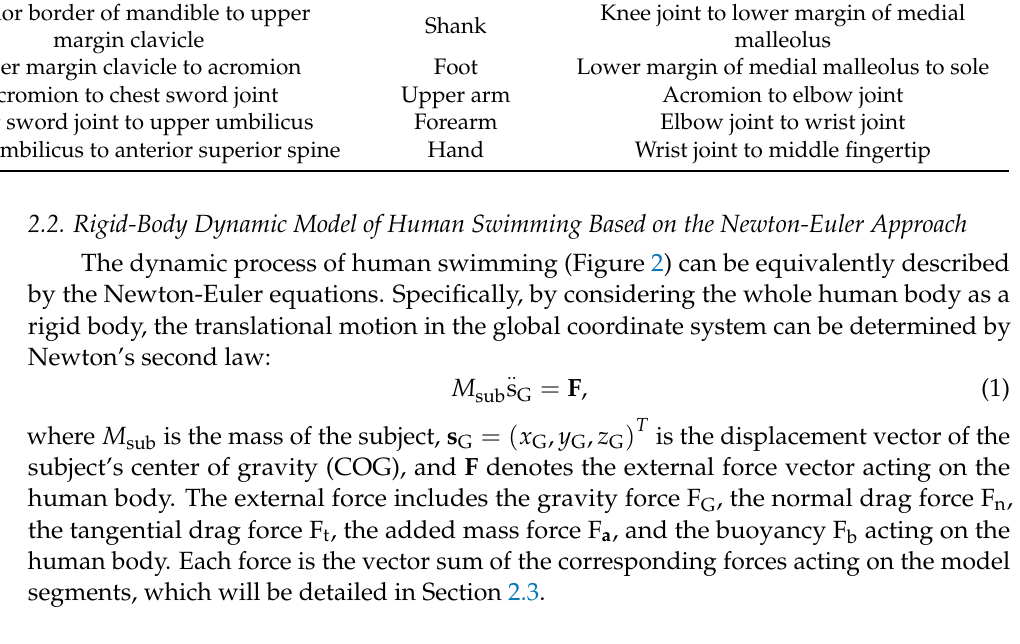
Figure 1. Geometric modeling of the human body. ( a ) 3D CAD model of the human subject based on point cloud data obtained via 3D scanning. ( b ) Multi-rigid-body model of the human body consisting of 18 segments. Table 1. Basis for human body segmentation [40].